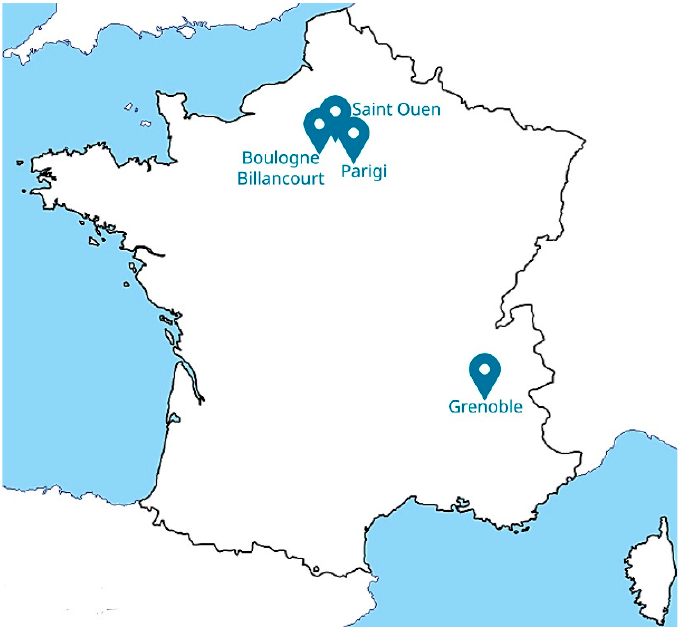
Figure 3. Localization of the selected EcoQuartiers. Source: Authors’ elaboration (2022).